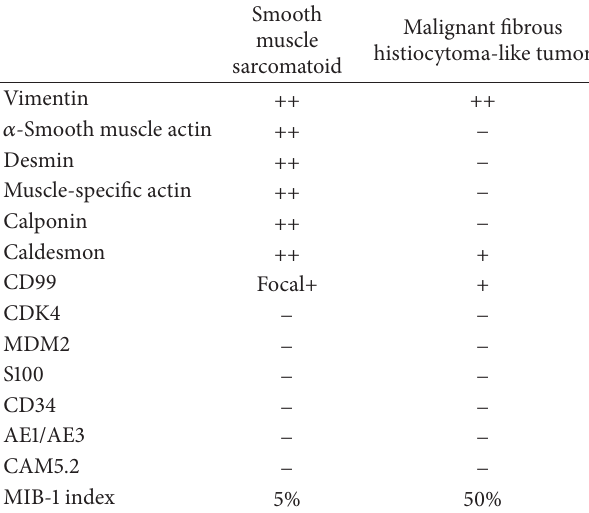
Table 1: Immunostaining of our